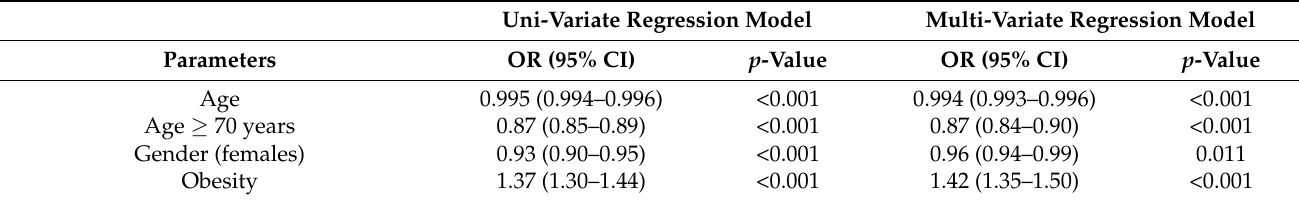
Table 2. Factors associated with pulmonary embolism in patients with paralysis in coprevalence with venous thromboembolism. Uni-Variate Regression